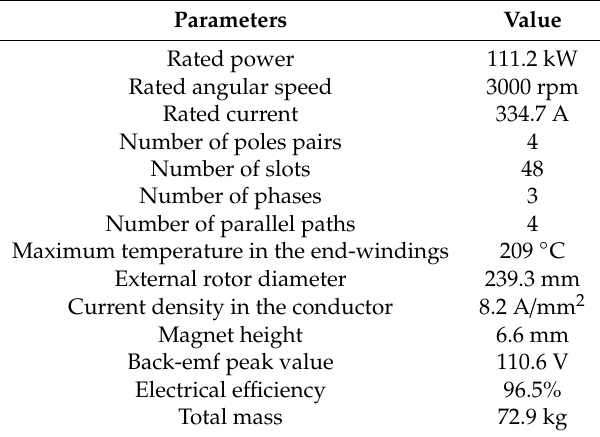
Figure 11. Plane with both objective functions: Initial population distribution (blue circles), final solution with best power density (red circle), and with highest rated power (green circle). For the final population, the position of the element with the best value of power (which also corresponds to the best value of the optimization problem) and the motor with the highest value of power density are depicted in the previous figures and are reported in Tables 4 and 5: Table 4. Problem 2: best power density motor.